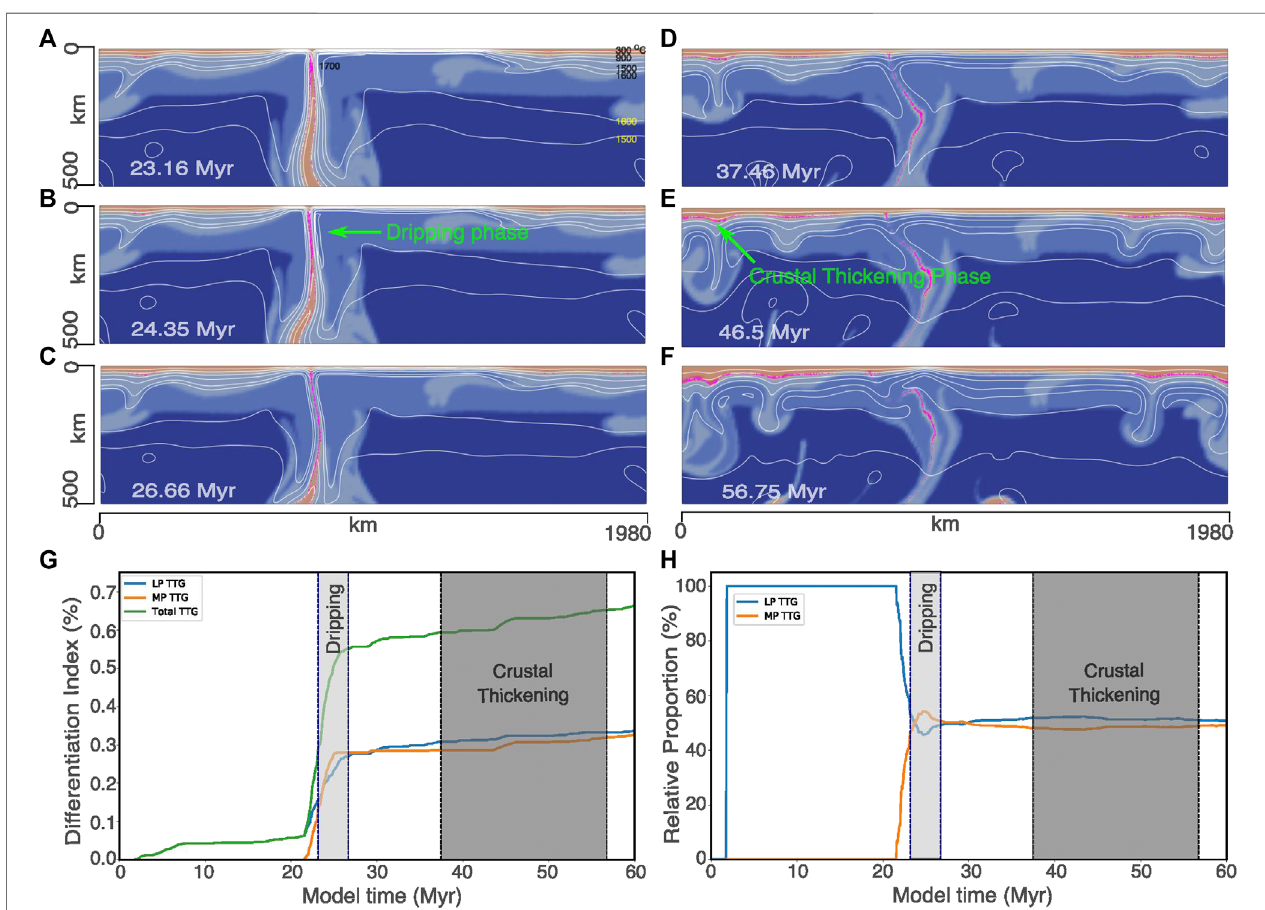
FIGURE6| Evolutionofamodelwithyieldstressof200 MPa,mantleT p of1,600 ° CandMoho-Tof700 ° C.Whiletheoverallmodelevolution (A – F) resemblesthatof thereferencemodel,anenhancedproductionoftonalite-trondhjemite-granodiorites(TTGs)atthesitesofthickenedcrust (E,F) isobservedinthismodel.Evolutionof (G) the TTG melt- and total TTG crustal volumes, and (H) relativeproportions of(low-pressure) LP- to(medium-pressure) MP-TTGsthrough time. Crustal growth during the thickeningphases (D – F) canbeseenbutthemajorgrowthstilloccursduringthedrippingphases (A – C) .Additionally,thismodelpredictsanequalproportionofLP- and MP-TTGs during the Archean, which contrasts with the preserved rock record.